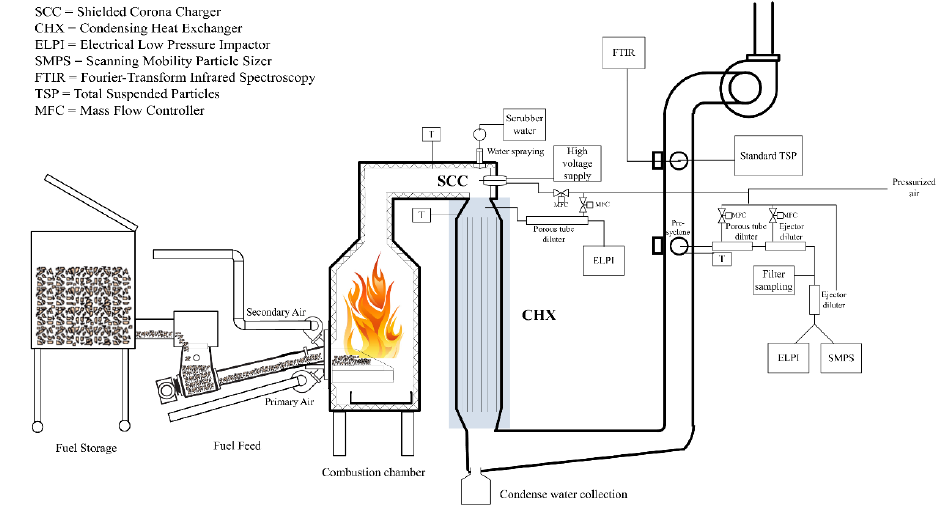
Figure 3. Experimental setup in the shielded corona charger–condensing heat exchanger (SCC–CHX) measurements.